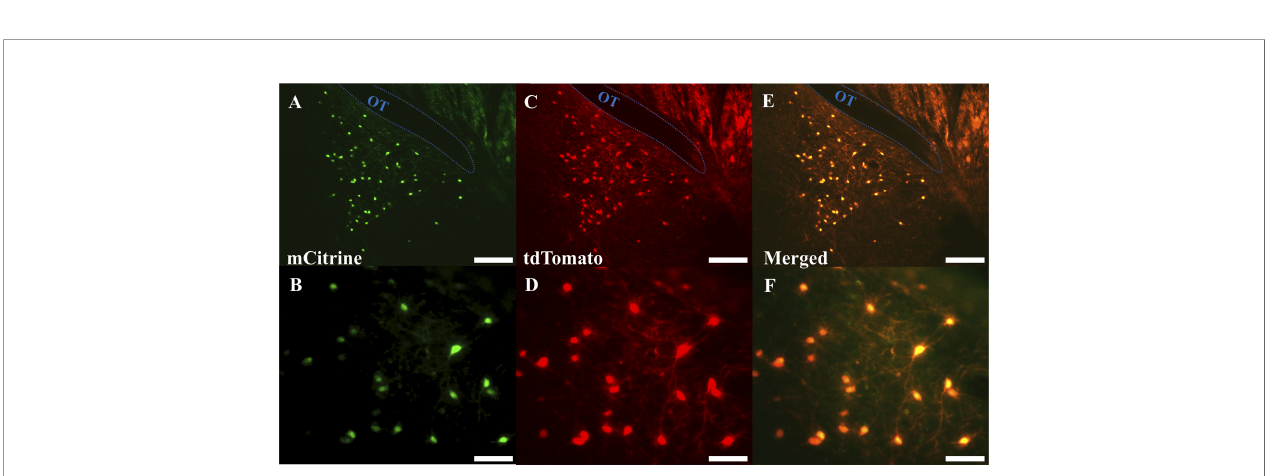
FIGURE 6 | Expression of AAV5-hSyn-DIO-HA-hM3D(Gq)-IRES-mCitrine in posterodorsal medial amygdala (MePD) Urocortin 3 (Ucn3) neurons. (A – F) Representative dual fl uorescence photomicrographs of the MePD from a Ucn3-cre-tdTomato female mouse injected with AAV5-hSyn-DIO-HA-hM3D(Gq)-IRES- mCitrine. Ucn3 neurons labelled with m-Citrine (A) and tdTomato (C) appear yellow/orange (E) . (B, D, F) are a higher power view of (A, C, E) respectively. Scale bars represent (A, C, E) 100 m m and (B, D, F) 25 m m; OT, Optic tract (blue